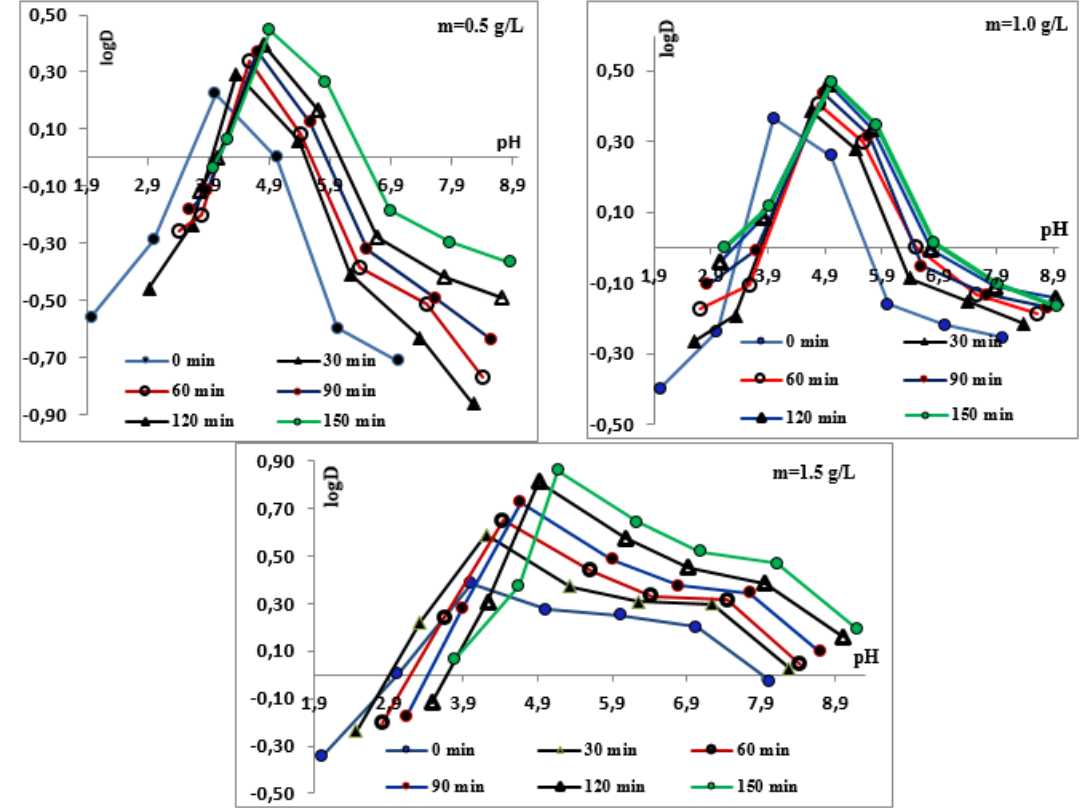
Figure 1. Log(D) versus pH for different amounts of OCP and different contact times.